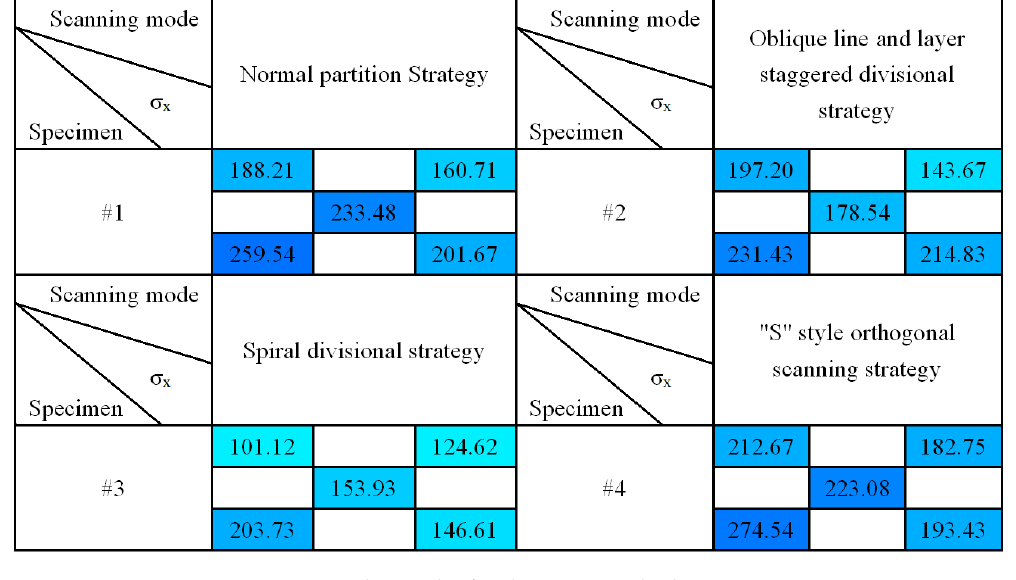
Figure 11. The result of X-direction residual stress σ x .